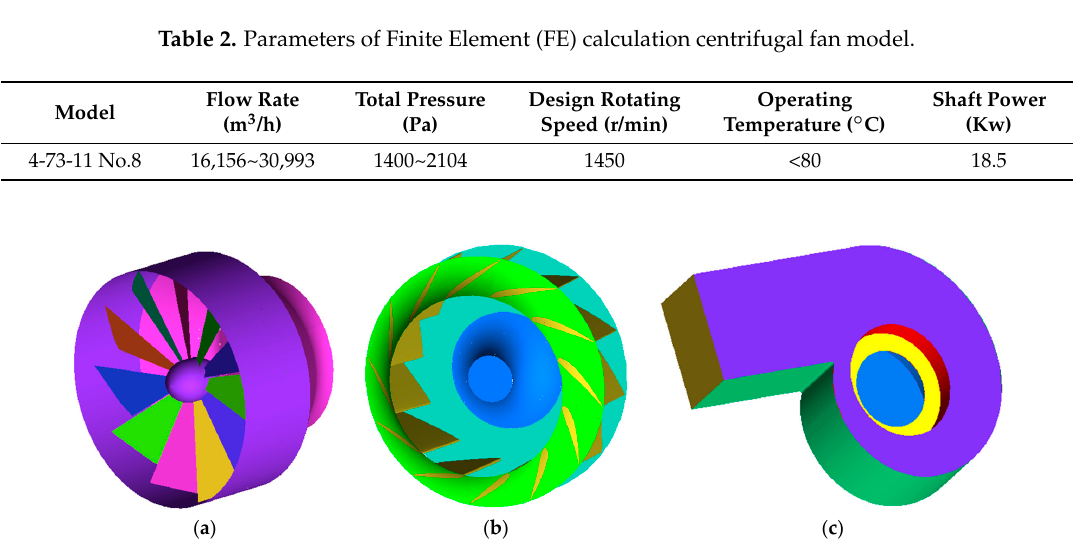
Table 2. Parameters of Finite Element (FE) calculation centrifugal fan model.